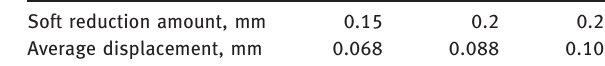
Table 1: Average displacement of solidification front under different soft reduction amount.